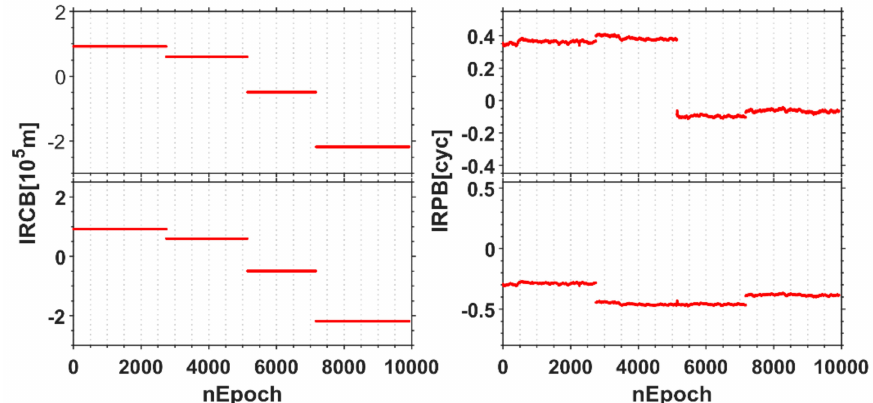
Figure 7. IRCB and IRPB estimation results once restart of the receiver. The panels from left to right represent IRCB and IRPB, whose rows from top to bottom denote B1 and B2,